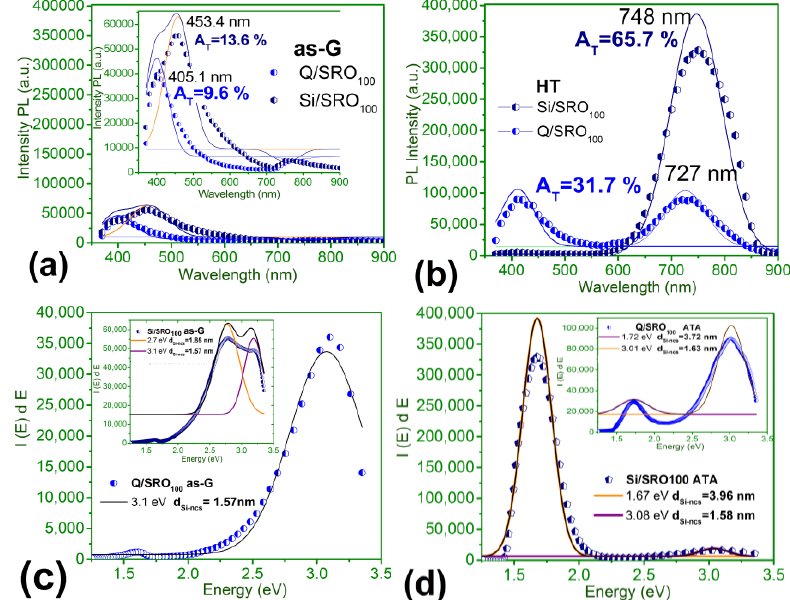
Figure 10. Photoluminescence of the SRO 100 films deposited by the HFCVD system under conditions ( a ) and ( c ) as-G and ( b ) and ( d ) with HT.